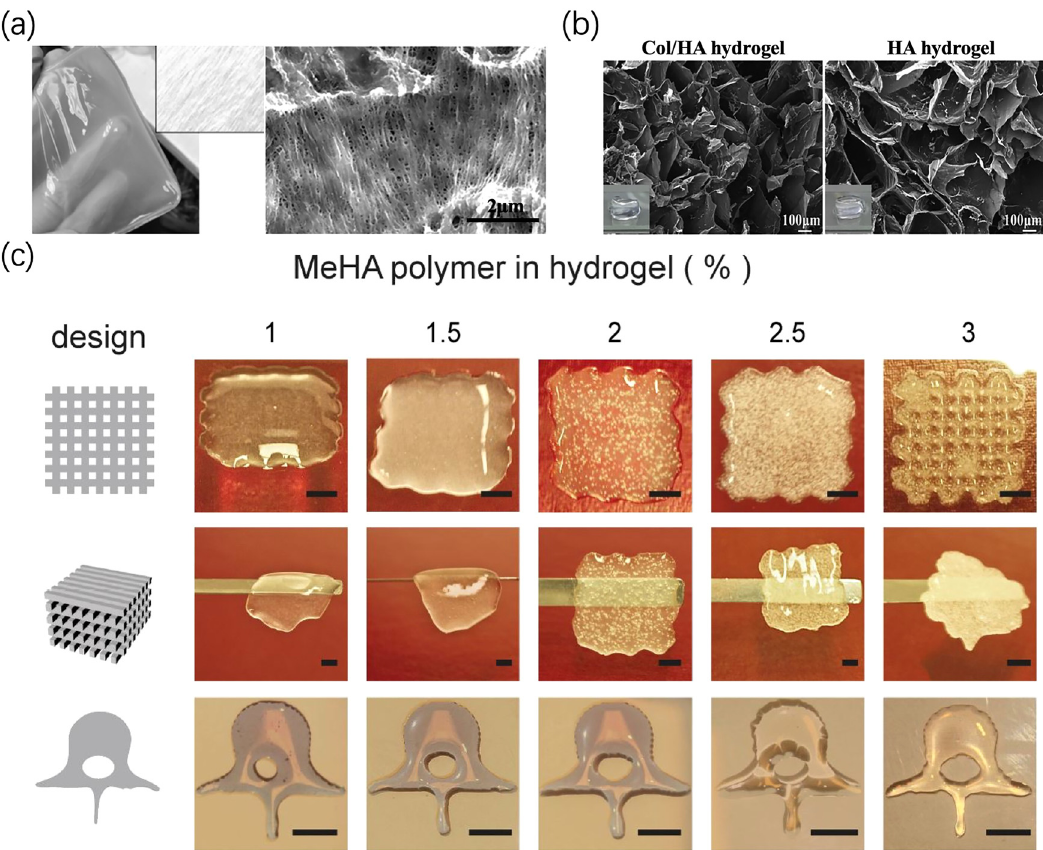
Figure 4: The GMHA showed a good printability and ability of anti - adhesion. ( a ) The hydrogel fi lm composed of alginate and GMHA [ 74 ] . ( b ) GMHA hydrogel [ 76 ] . ( c ) The printability of MeHA [ 79 ]